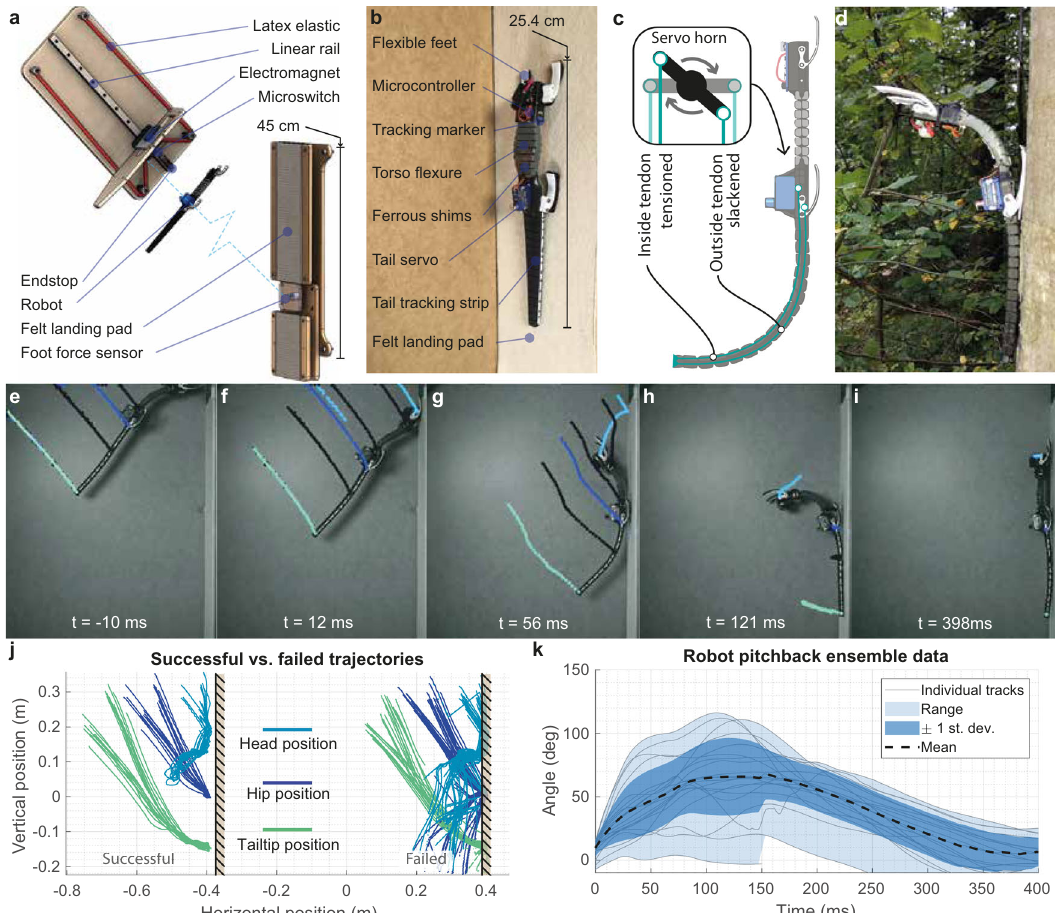
Fig. 5 Landing pitch-back behavior in robotic physical model with tail. (Supplementary Movie 2). a Rendering of catapult and landing pad setup, showing robot model and force plate. Launcher is shown closer to perch surface than in the real experiment for clarity. b Photograph of the soft robotic lander on the experiment landing surface. c Illustration showing the tendon driven tail ’ s operation with a servo-tensioning tendon to de fl ect the tail. d Image of the soft robotic lander perched on a tree outdoors, showing large pitch-back. e – i Robot model landing sequence, showing the pitch-back behavior and pose estimation from software (DeepLabCut). j Tracking result, showing the head, hip, and tail tip paths for successful ( n = 22) and unsuccessful ( n = 16) landings for a passive tail. k Ensemble mean of 22 successful landings out of 38 trials, showing the spread of pitch-back behavior ( n =